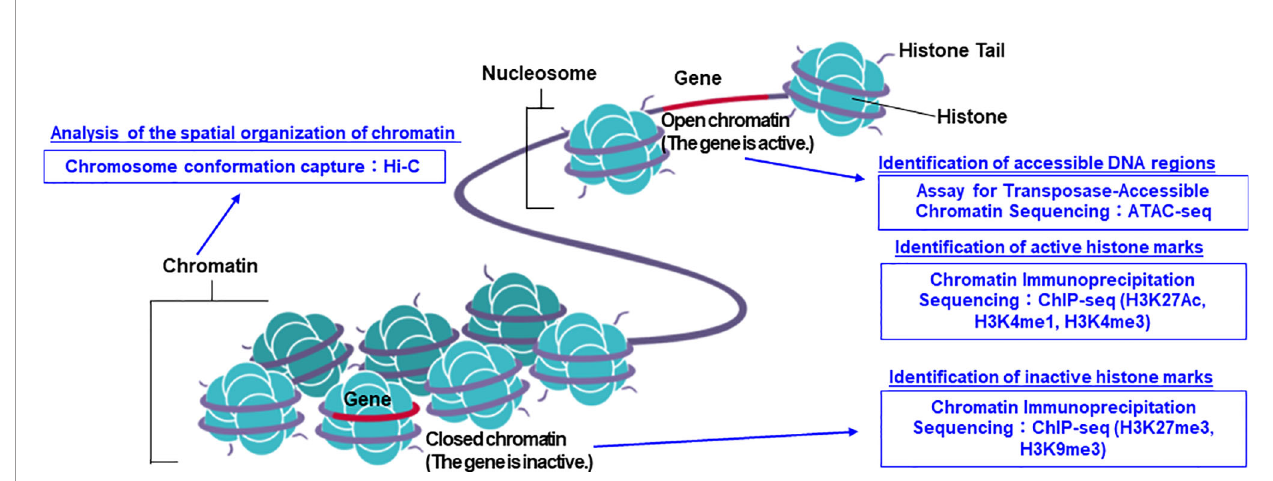
FIGURE 1 | The summarized fi gure of chromatin structure and epigenomic analysis methods. ChIP-seq, ATAC-seq, and Hi-C methods can be used to predict the state of transcriptional activation or inactivation, and chromatin structure. Image credit: Shutterstock.com/ellepigra fi